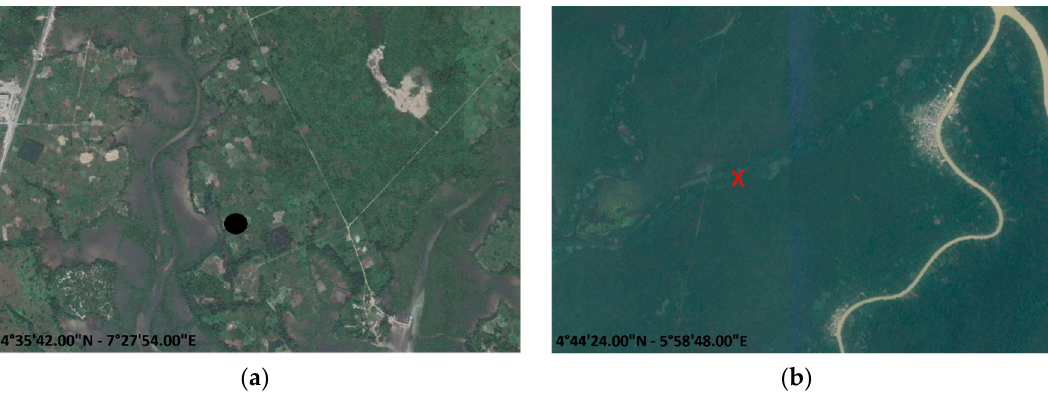
Figure 13. Two examples of false positives by: ( a ) RST-FLARE; ( b ) VNF. In background are GoogleEarth ® images of ( a ) 19/12/2013 and ( b ) 23/12/2015. The visual inspection has been carried out for the whole temporal period exploiting the GoogleEarth timeline tool (clock button).